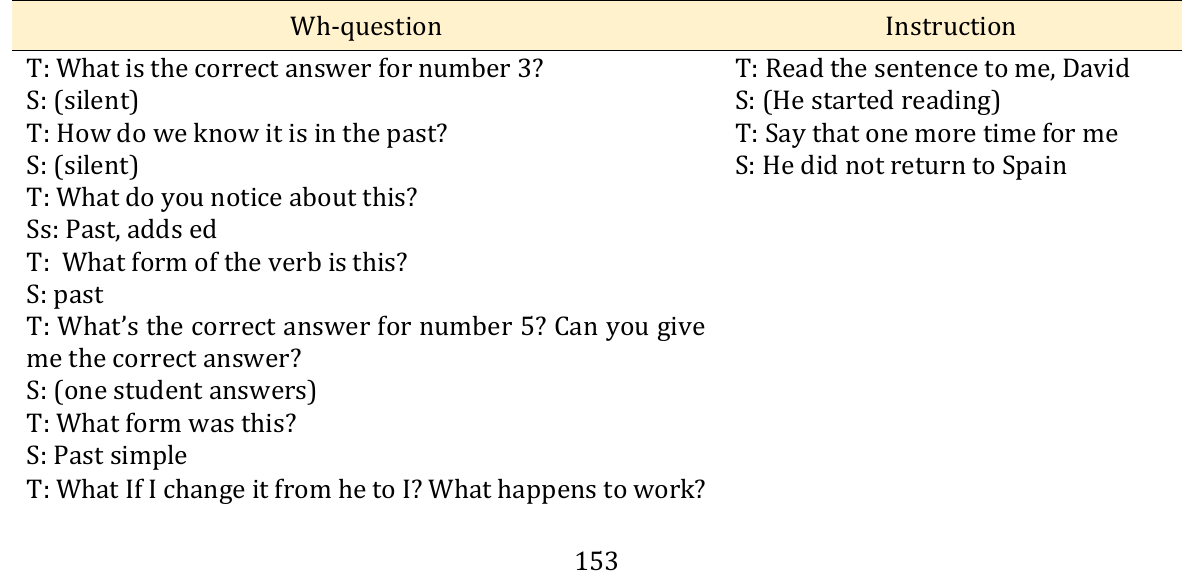
Table 1. Open-ended questions in the presentation